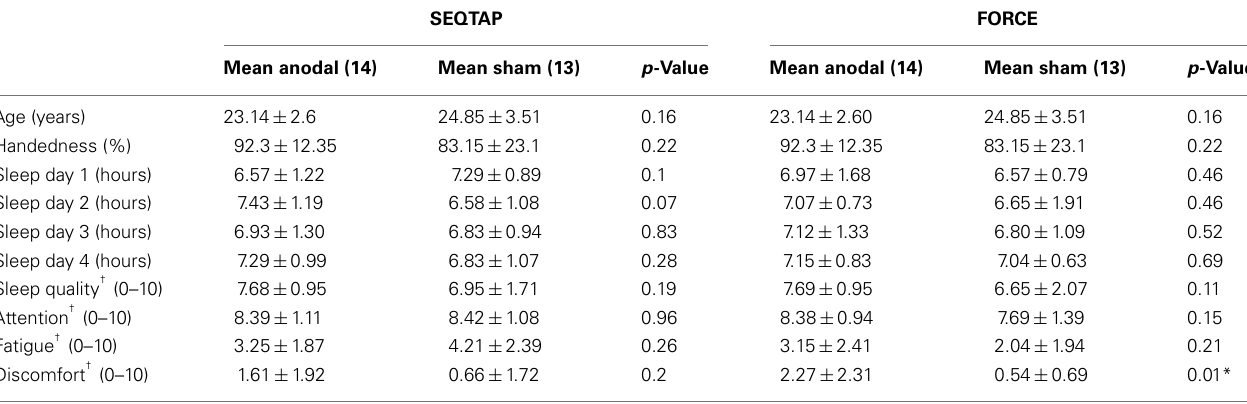
Table 2 | Psychometric